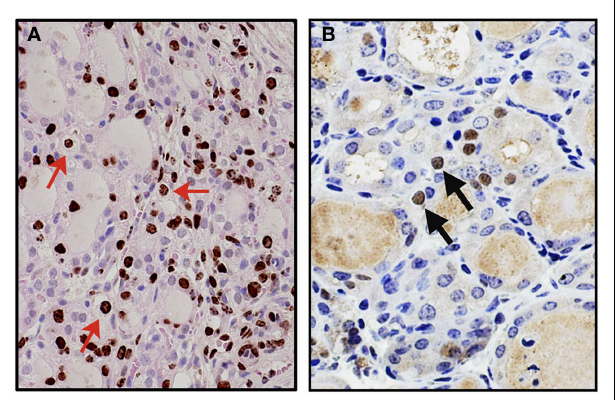
FIGURE 1 |Appearance of clear cells 2weeks after partial thyroidectomy . (A) Immunohistochemistry for BrdU (brown color) counterstained with light H&E. Many clear cells are positive for BrdU as representatives shown by red arrows. (B) Immunohistochemistry for Foxa2 (brown color), counterstained with hematoxylin. Clear cells expressing Foxa2 are indicated by